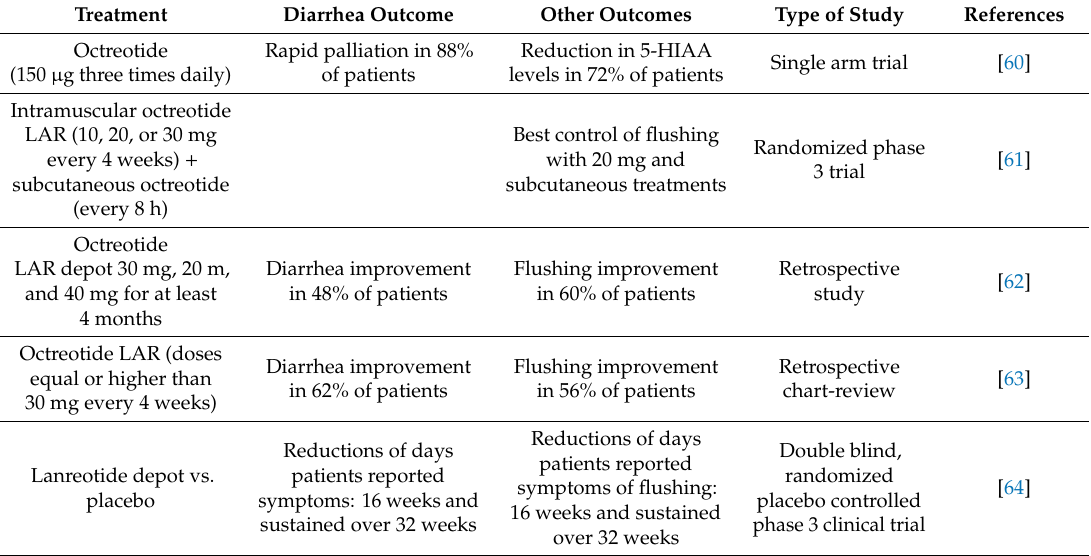
Table 5. Diarrhea outcome associated with carcinoid syndrome upon treatment with somatostatin analogs (SSAs) and tryptophan hydroxylase